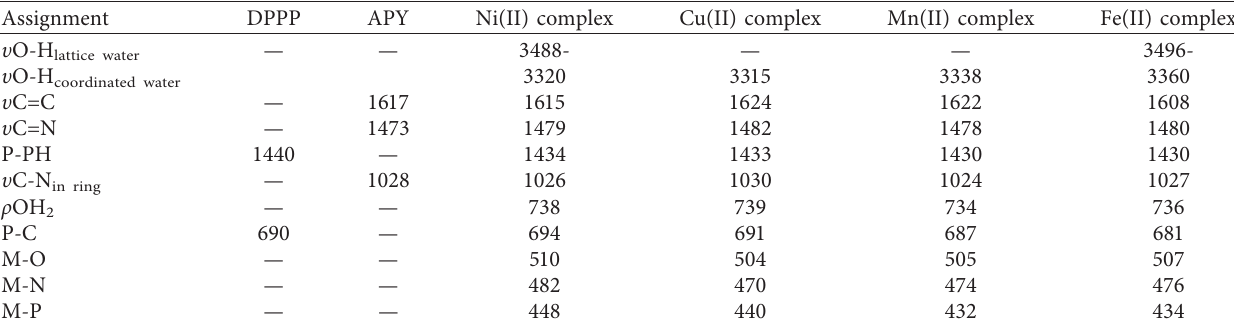
Table 2: The infrared spectral data (cm − 1 ) of the ligand and their complexes.